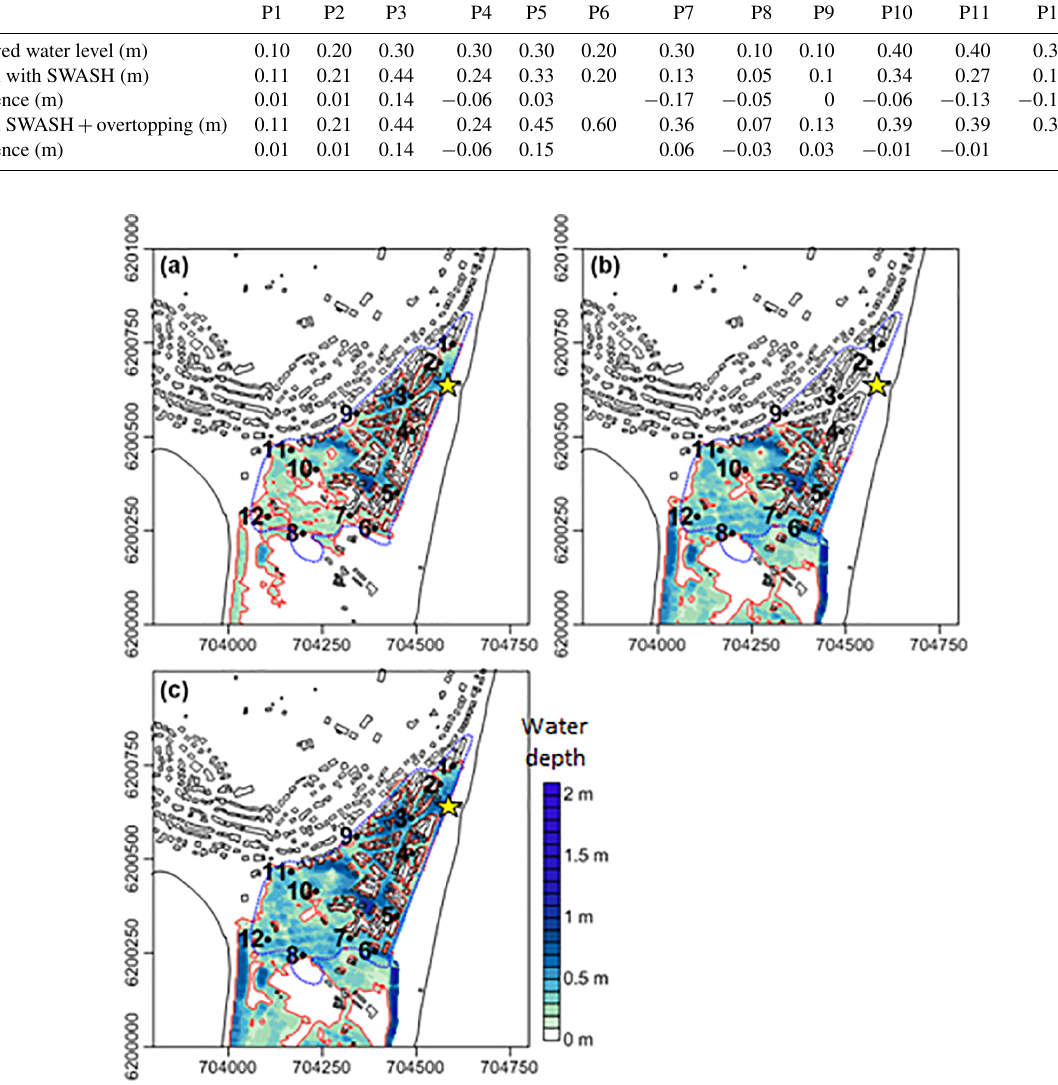
Figure 10. Flood simulation results for the zone A (Leucate Plage) after sea front wall breach (the yellow star indicate the location of the breach). The blue dotted line represents the reconstructed flood extension, and the red line the simulated flood extension. (a) Propagation of the water volume passing through the breach, (b) propagation of overtopping water volume and (c) propagation of the two sources of